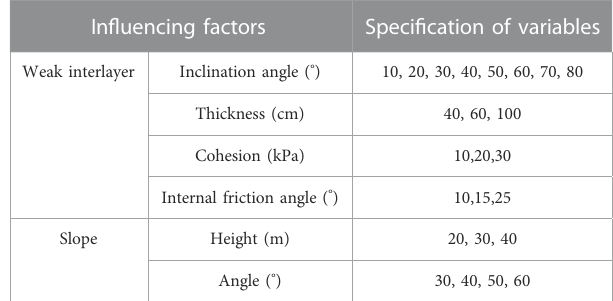
TABLE 1 In fl uencing factors